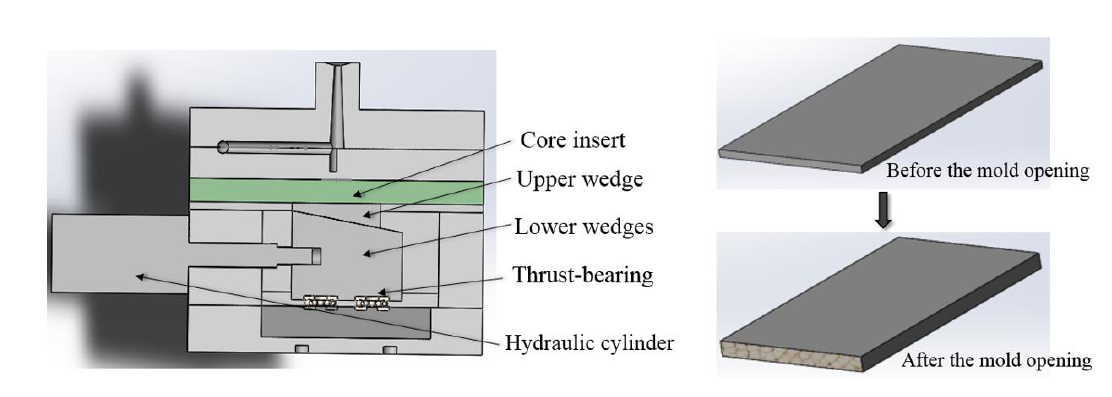
Figure 1. Cross-section of the mold and schematic of the